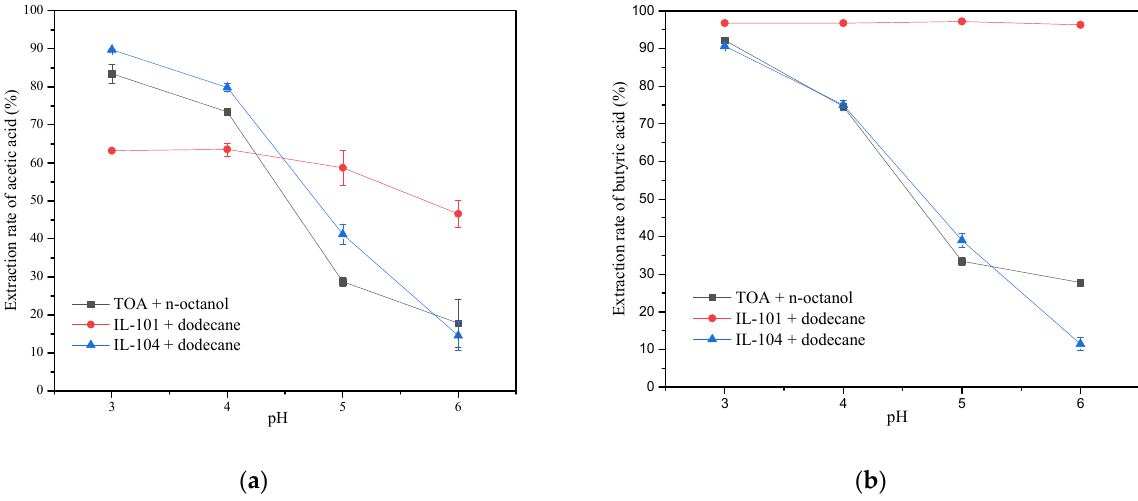
Figure 1. Extraction rates of acetic acid ( a ) and butyric acid ( b ) using different solvents at different pH.